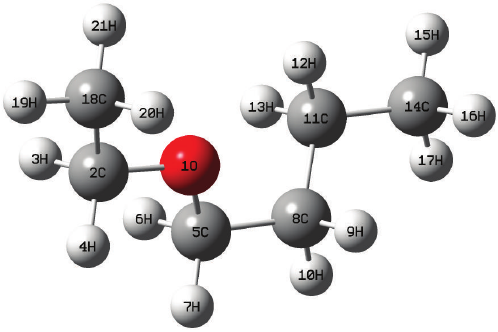
F 3: Spectrum of the complex refractive index of NBEE in the lower MIR range (2000–560cm